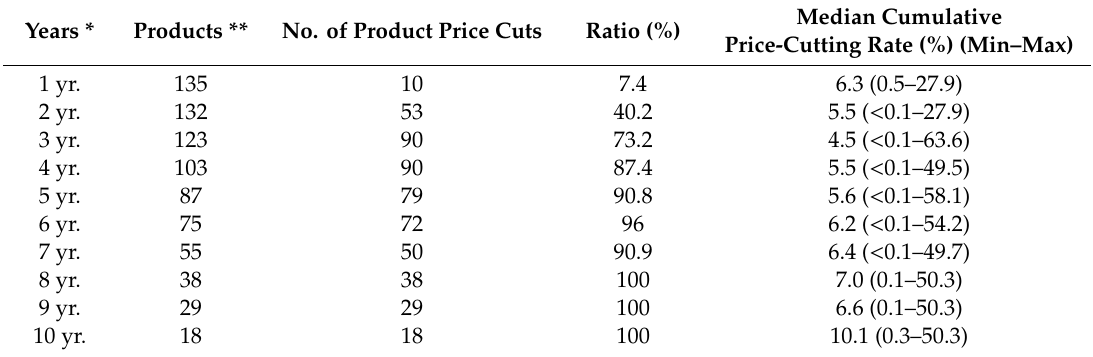
Table 4. Cumulative price-cutting rate of new drugs after listing by year.